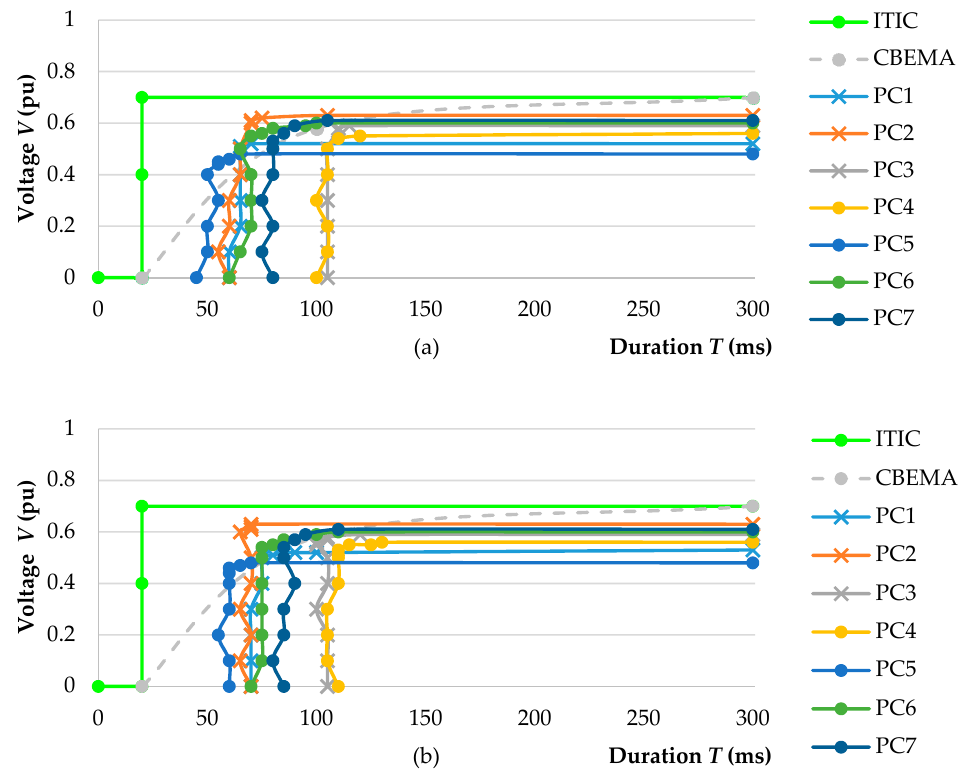
Figure 3. Voltage–tolerance characteristic of personal computers: ( a ) at phase instant of voltage 0° and ( b ) at phase instant of voltage 90°.